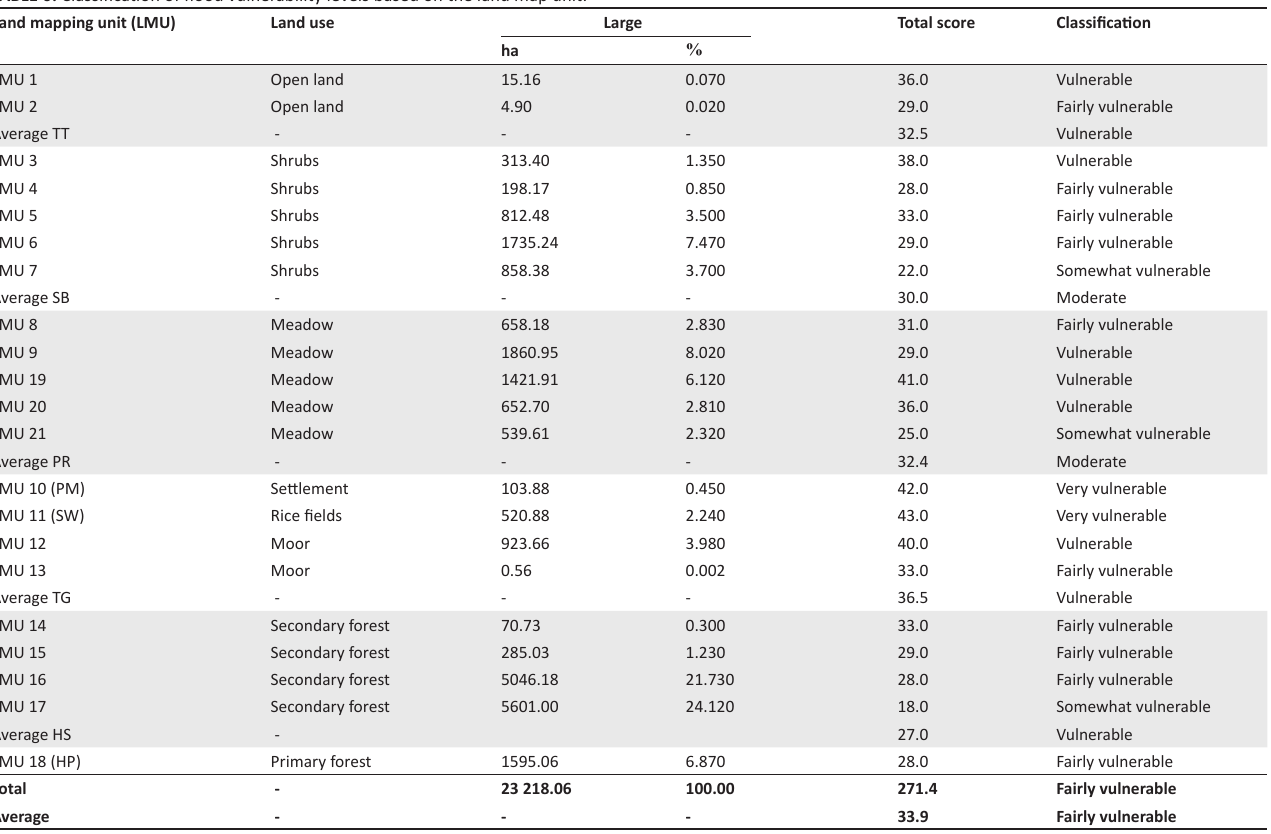
TABLE 6: Classification of flood vulnerability levels based on the land map unit. Land mapping unit (LMU)